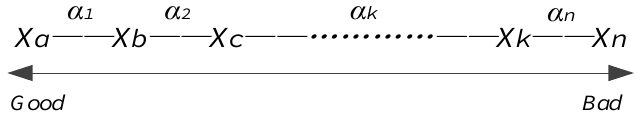
Figure 4. Maximal relational tree with closeness degrees.